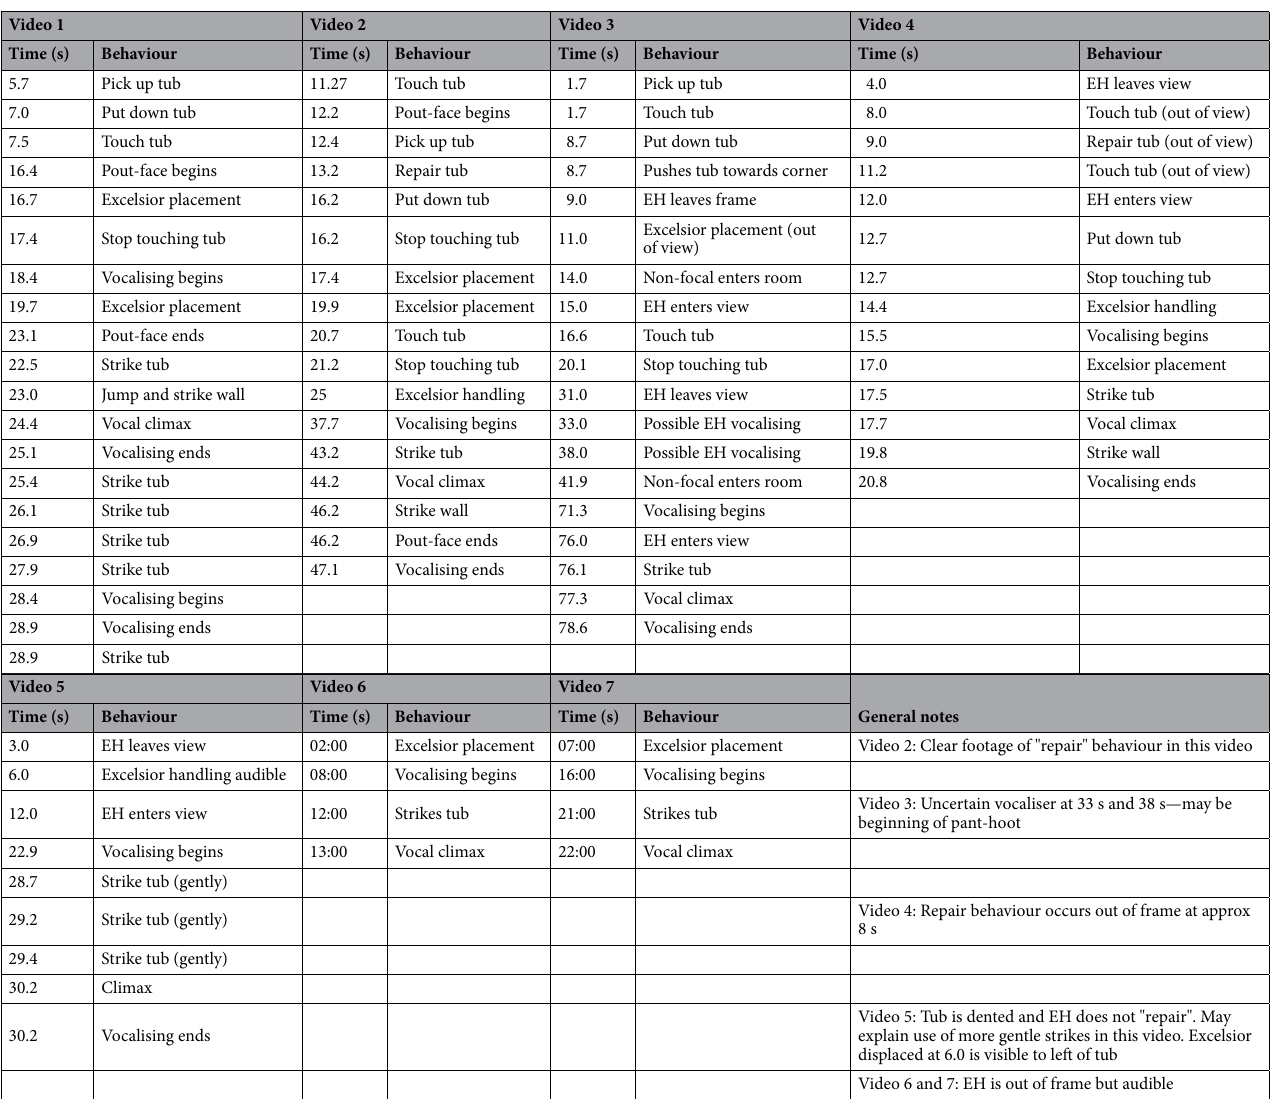
Video 5: Tub is dented and EH does not "repair". May explain use of more gentle strikes in this video. Excelsior displaced at 6.0 is visible to left of tub Video 6 and 7: EH is out of frame but